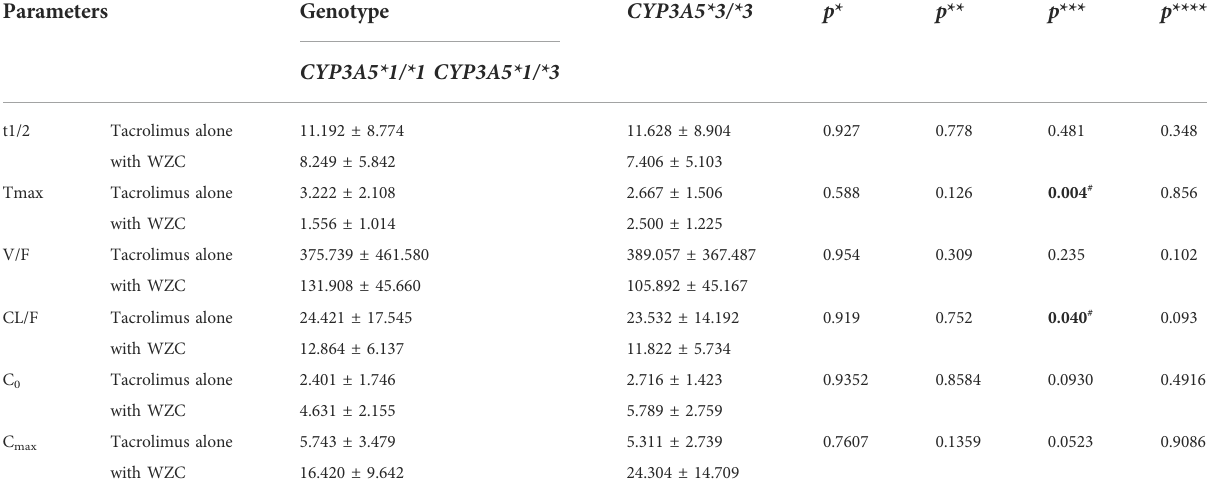
TABLE 3 Pharmacokinetic parameters of tacrolimus with or without WZC with different CYP3A5 genotype ( n = 15). Parameters